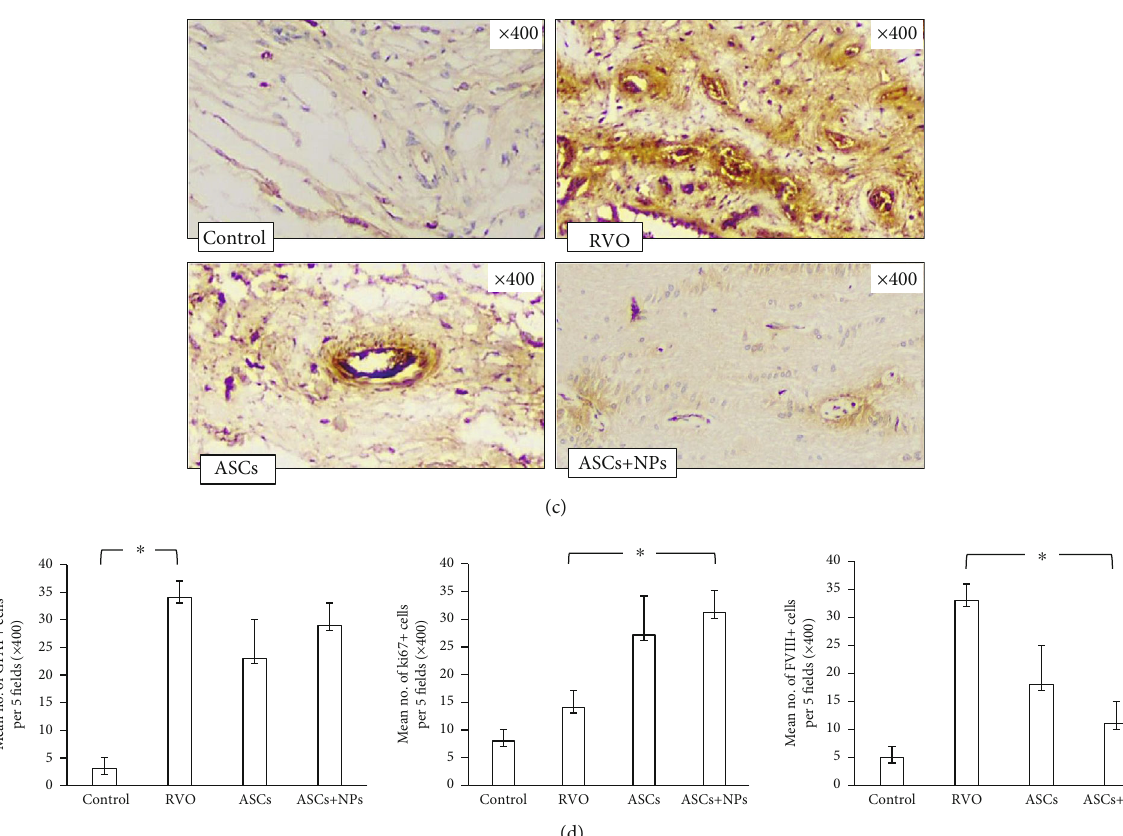
Figure 8: Immunohistochemistry staining of retina sections for GFAP, k-i67, and factor VIII reveals. (a) Intense response to damage with high GFAP secretion is con fi rmed with positive GFAP staining observed in the RVO group as a result of cell activation followed by subsequent decrease of positive signal at the height of the ganglion layer in the treatment groups. (b) Increased cell proliferation for tissue cellular restoration is estimated by counting several ki-67+ cells in the treatment groups (in fi ve randomly selected fi elds) in relation to the control group and RVO group. (c) Limitation of pathological neovascularization (FVIII staining) is presented with decreased platelet concentration on injured vessels and counting of multiple pathological new vessels in the RVO group (in fi ve randomly selected fi elds) in relation to the control group with important limiting of their number in the treatment groups. (d) Mean of positive cells per fi ve fi elds. Data are expressed as the mean ± SD ( ∗ P < 0 : 05 ; n = 2 ). GCL: ganglion cell layer; INL: inner nuclear layer; IPL: inner plexiform layer; ONL: outer nuclear layer; OPL: outer plexiform